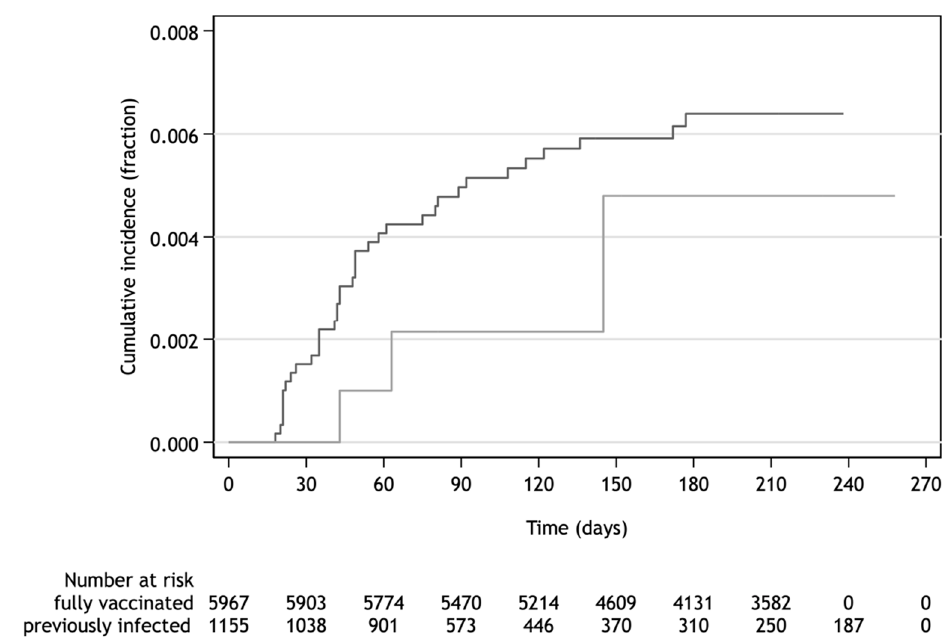
Figure 5. Cumulative incidence of any SARS-CoV-2 infection among fully vaccinated and previously infected.